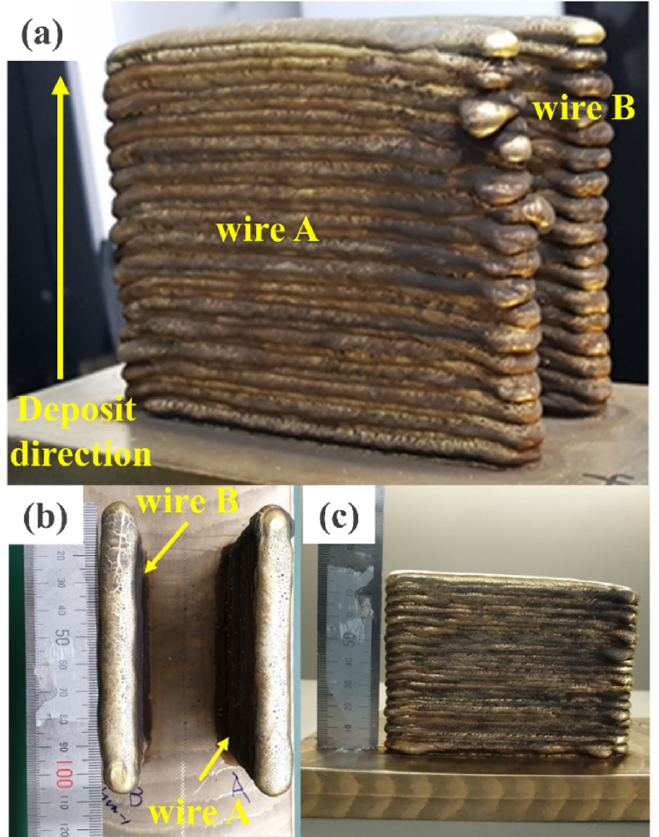
Figure 4. Additively-manufactured NAB components and 3D X-ray analysis; ( a ) isometric view ( b ) ( b ) top view ( c ) side view. top view ( c ) side view.